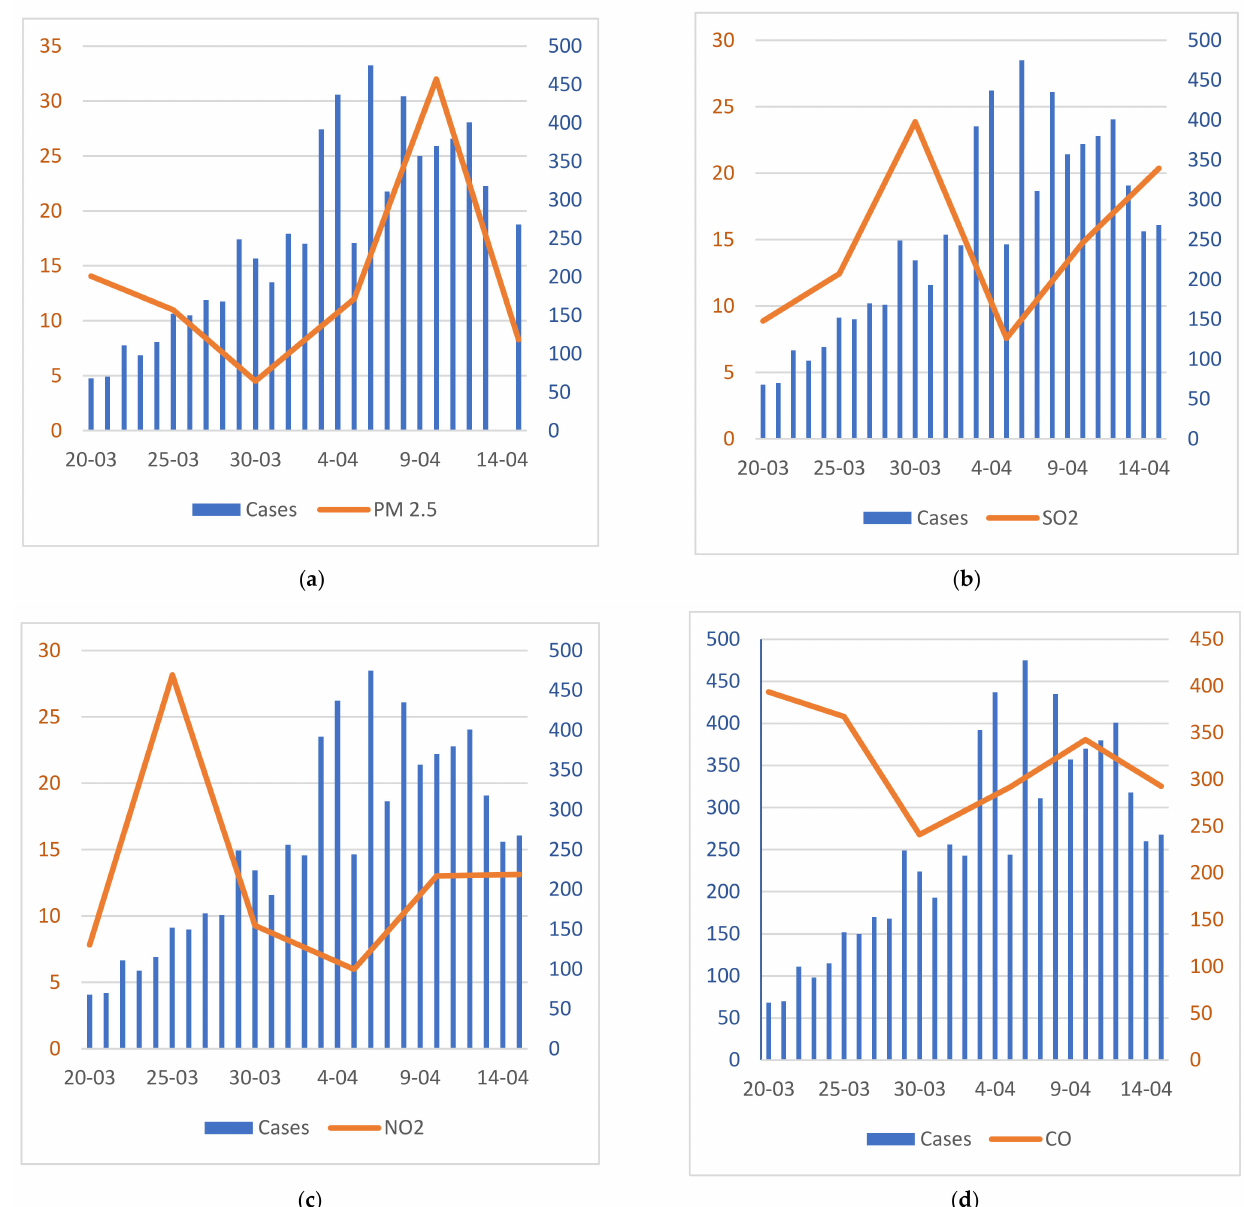
Figure 16. Comparison of the number of morbidity cases and the concentration of selected substances ( µ g/m 3 ) in Poland on 15 March 2020–15 April 2020. Source: Own elaboration, based on data from Eurostat, European Environment Agency (EEA) and Copernicus Atmosphere Monitoring Service (CAMS) [32,47]. ( a ) PM 2.5 ; ( b ) SO 2 ; ( c ) NO 2 ; ( d )